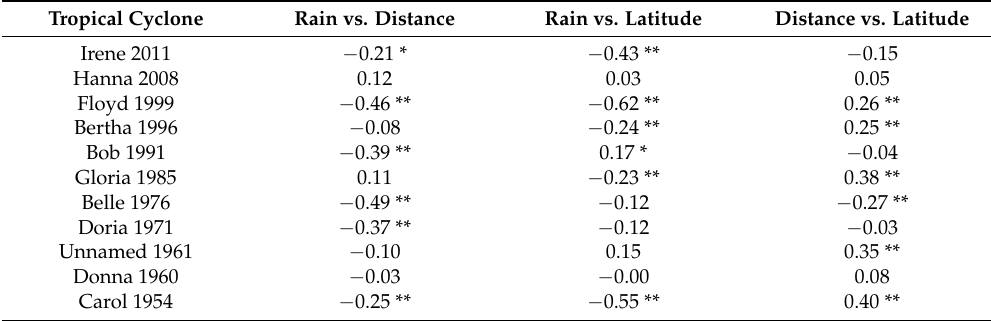
Table 3. Spearman’s rank correlation coefficients for the top 10% of rainfall totals left of track for each storm between rainfall total, distance from the storm track, and latitude. Tropical Cyclone Rain vs. Distance Rain vs. Latitude Distance vs. Latitude